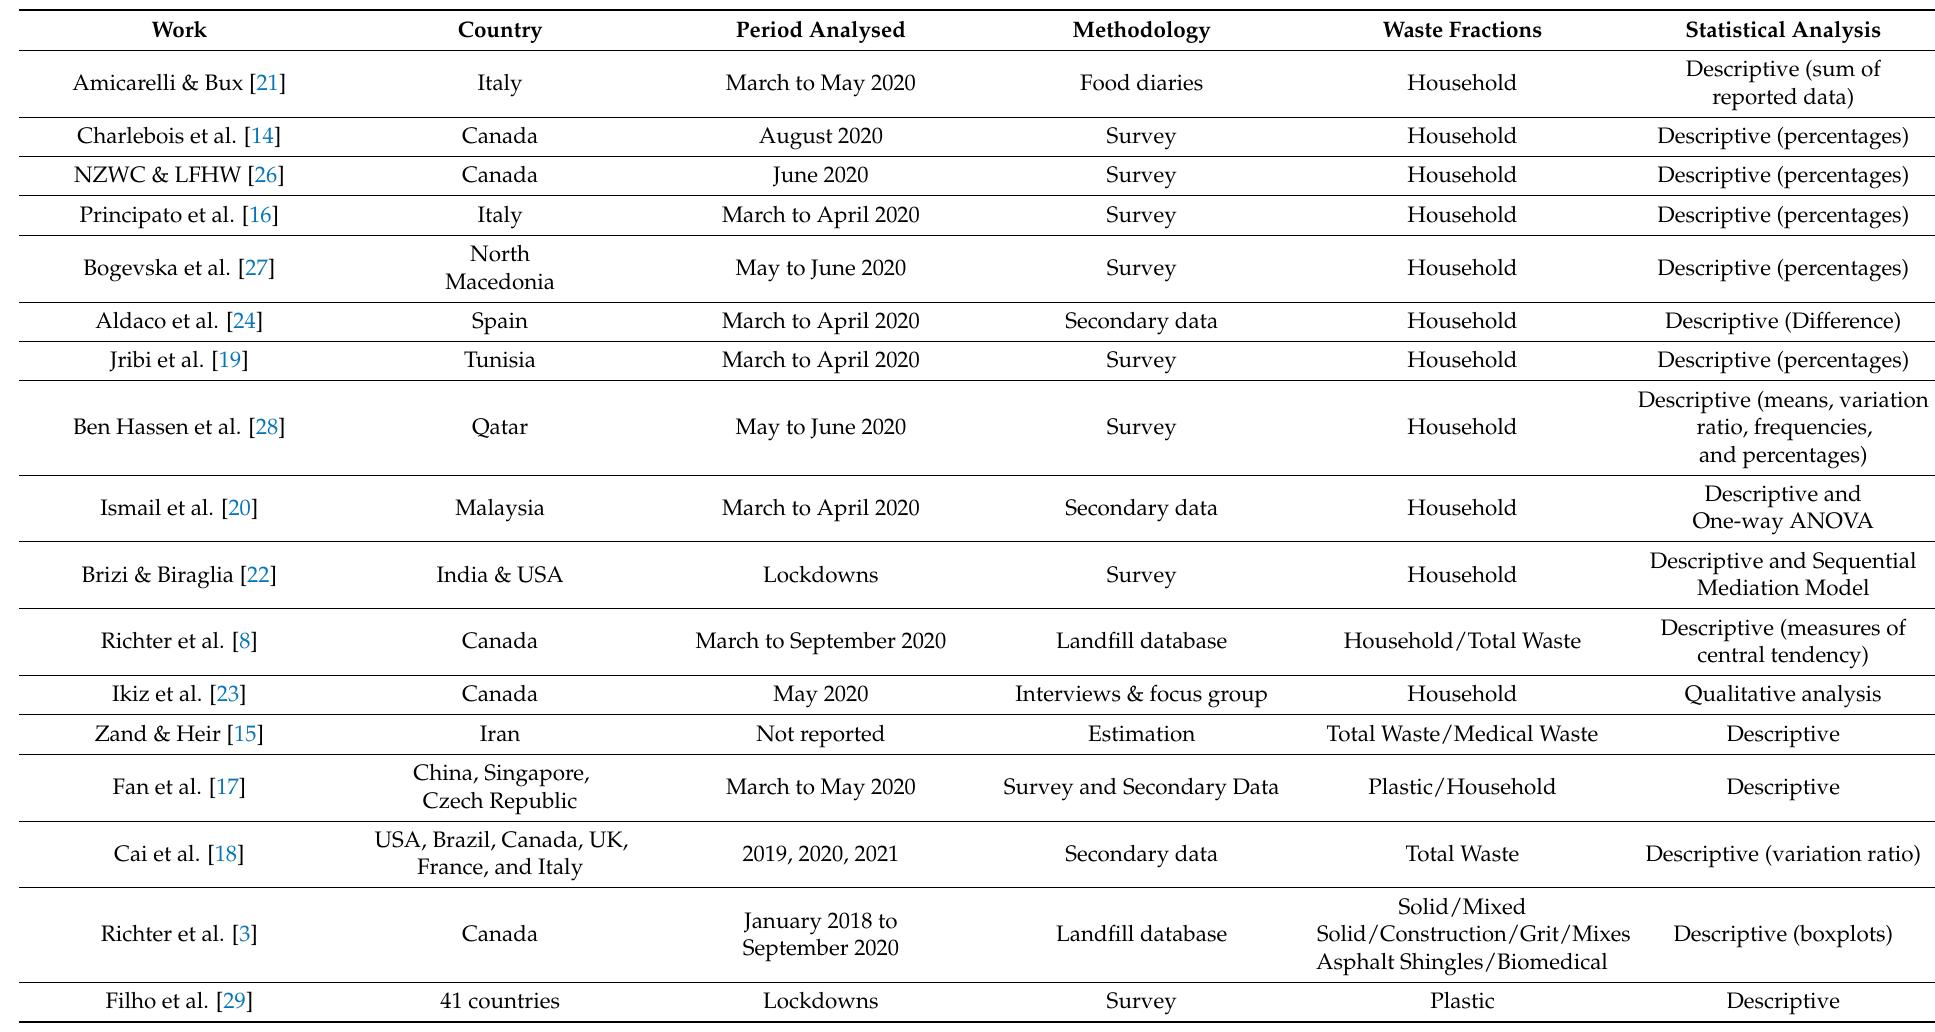
Table 1. Summary of preliminary works on waste generation differences found between pre-COVID-19 and COVID-19